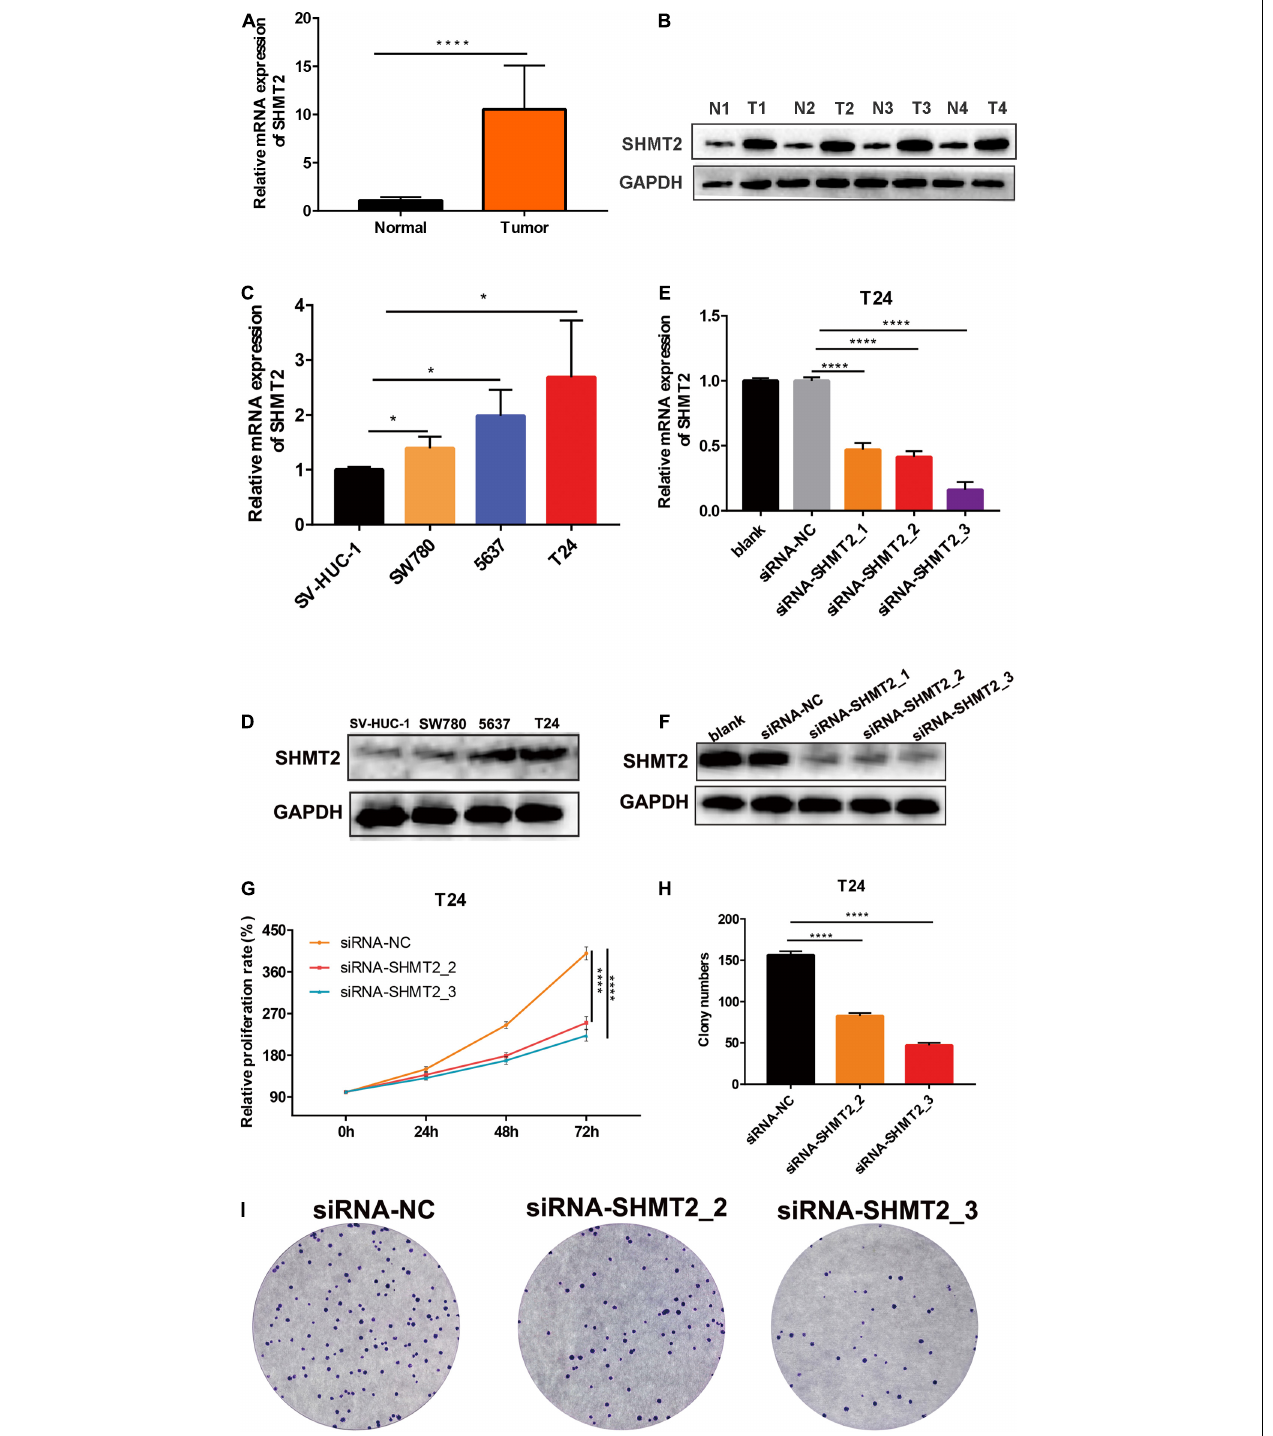
FIGURE 7 | Knockdown of SHMT2 inhibited bladder cancer cell proliferation. (A) SHMT2 mRNA expression level was higher in bladder cancer tissues than that in normal tissues (**** P < 0.0001). (B) Representative western blotting images showed that SHMT2 protein expression level was higher in bladder cancer tissues. (C) SHMT2 mRNA expression level was higher in BLCA cell lines (SW780, 5637, and T24) than that in bladder normal cell line SV-HUC-1 (* P < 0.05). (D) SHMT2 protein expression level was higher in BLCA cells. (E,F) SHMT2 mRNA and protein expression levels were examined in SHMT2-silenced T24 cells (**** P < 0.0001). (G) Knockdown of SHMT2 decreased the BLCA cell proliferation rates using CCK-8 assay. ( n = 3; **** P < 0.0001). (H,I) Knockdown of SHMT2 reduced the colony numbers, graph illustrating quantified values ( n = 3; **** P < 0.0001). CCK-8, cell counting kit-8, P -value < 0.05 was recognized as statistically